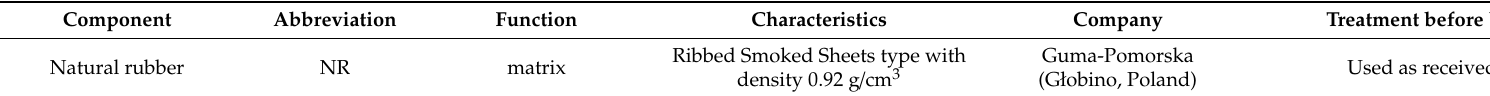
Table 1. Characteristics of used